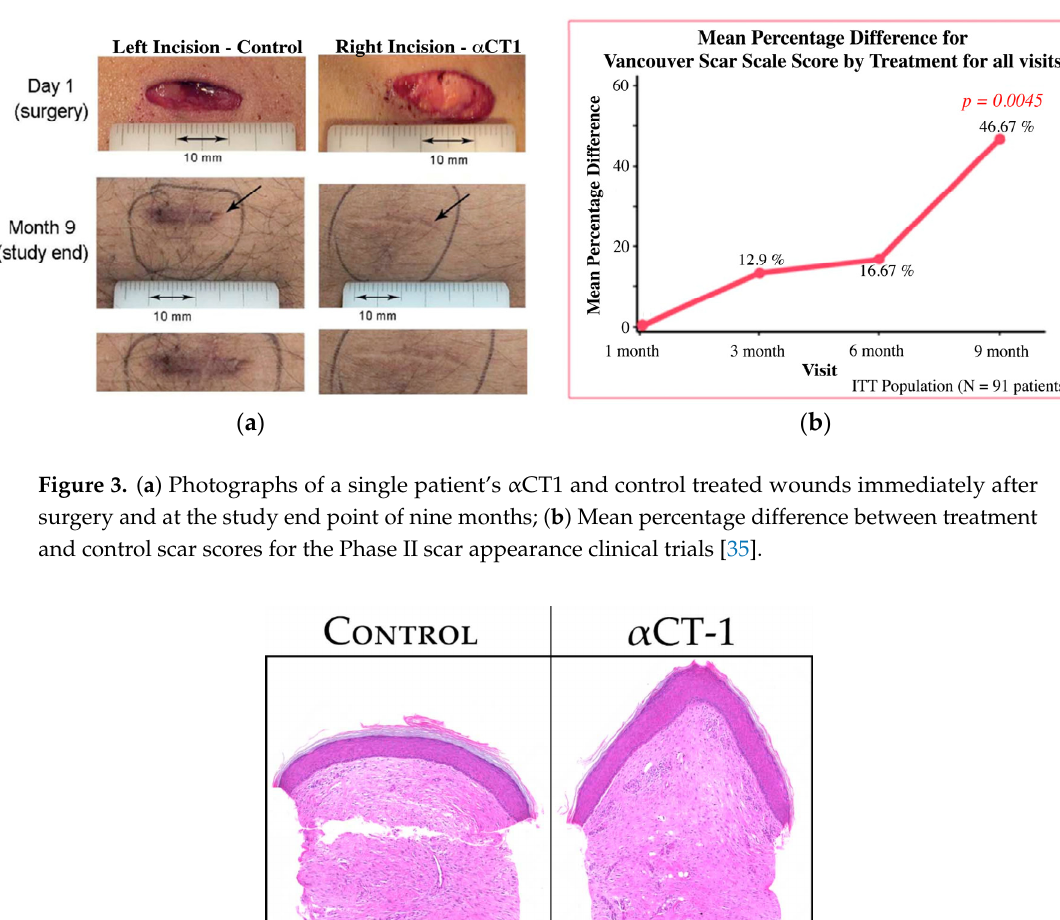
Table 1. Summary of completed alpha connexin carboxyl terminus 1 ( α CT1) clinical trials.